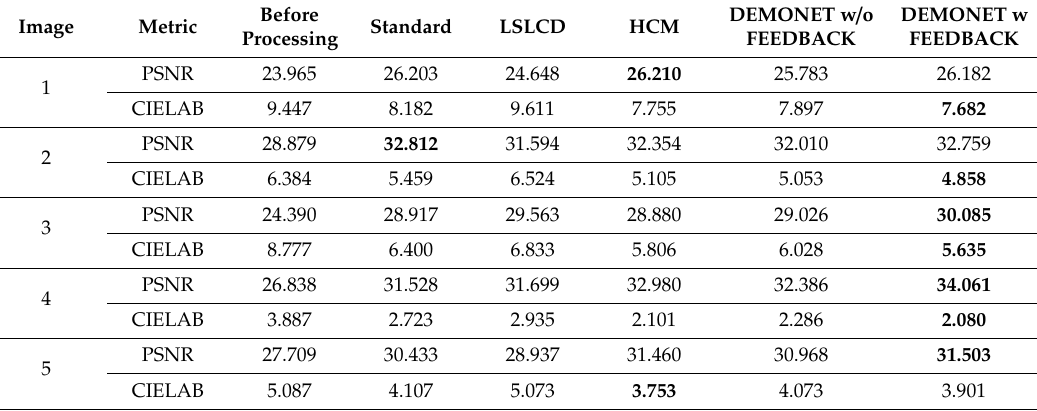
Table 2. PSNR and CIELAB metrics of di ff erent algorithms: IMAX data. Bold numbers indicate the best performing method in each